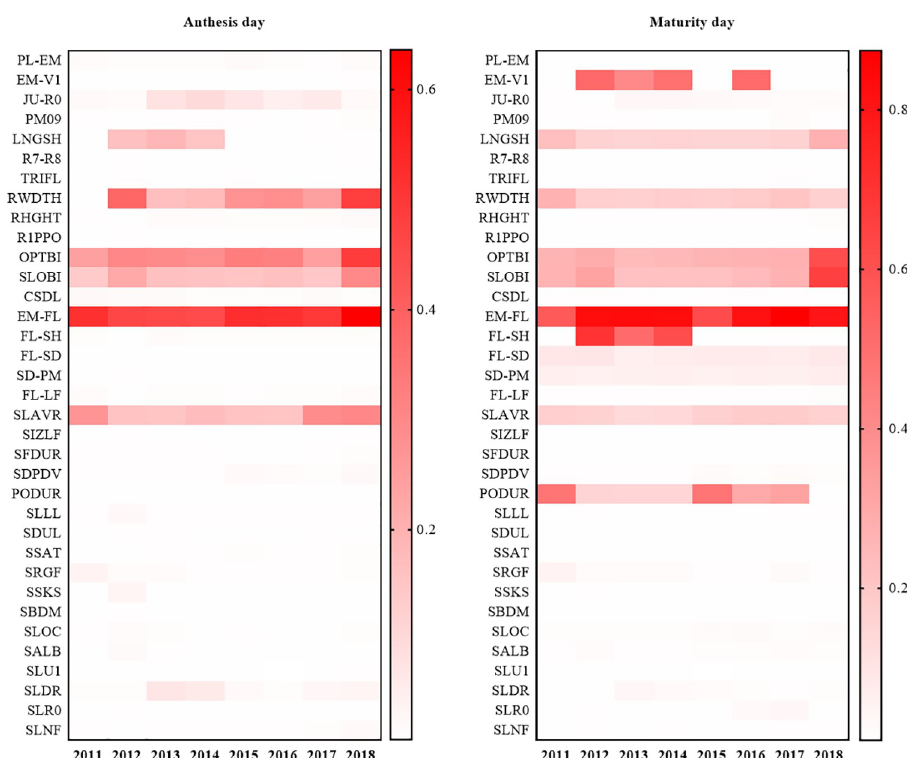
Fig 1. Temporal sensitivity indices for days to flowering and maturity (2011–2018). Note . I: ecotype parameters; II: genotype parameters; III: soil